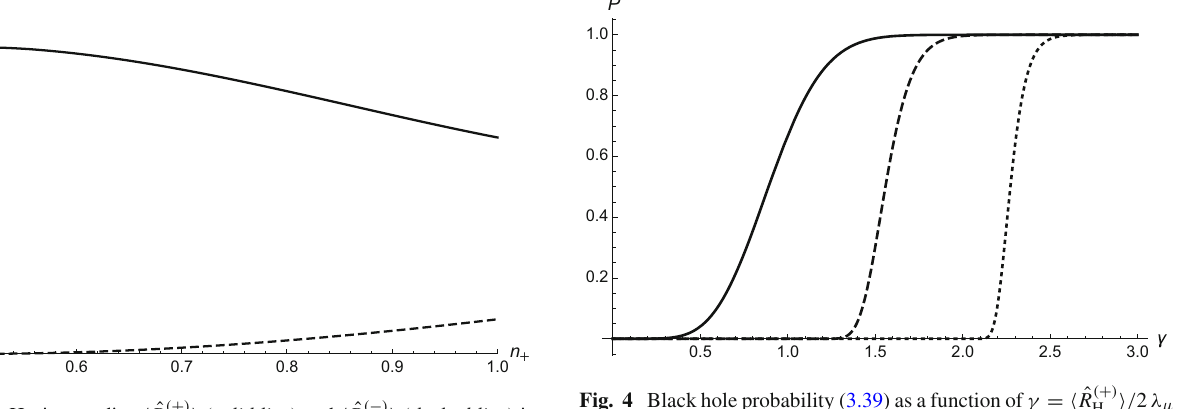
Fig. 2 Horizon radius (cid:7) ˆ R ( + ) Planck length units for N = 100 and γ = 2